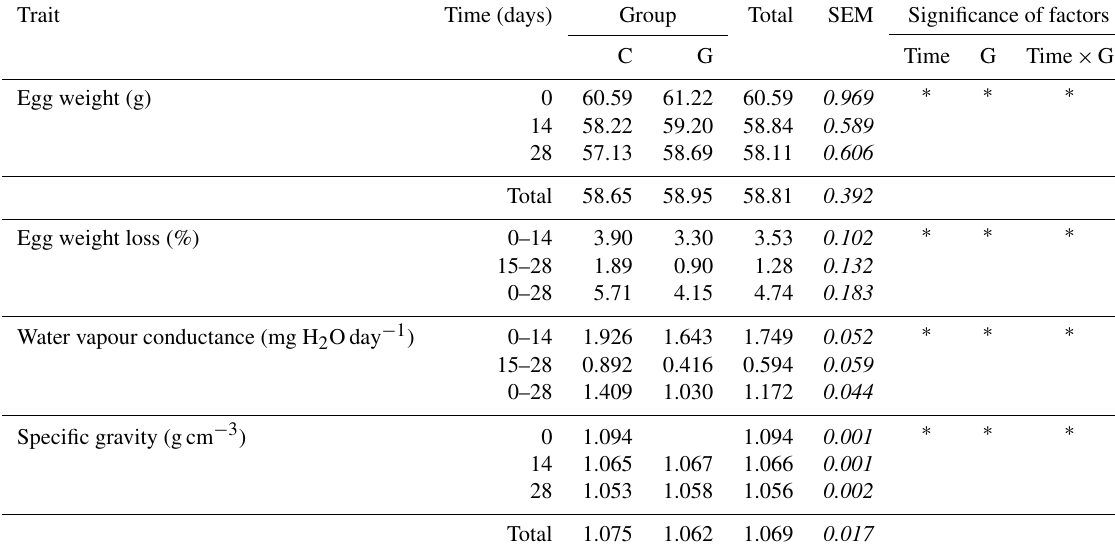
Table 2. Traits of the whole egg in the control and experimental groups. Trait